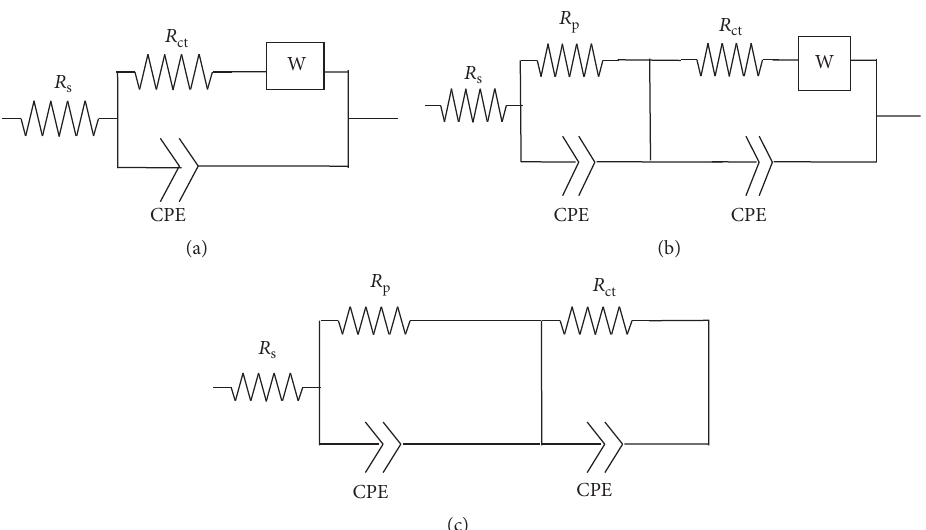
Figure 8: Equivalent circuits used in the fitting of the impedance results: (a) PEDOT, (b) PANI, 1mM PPy and 10mM PPy, and (c) 5mM